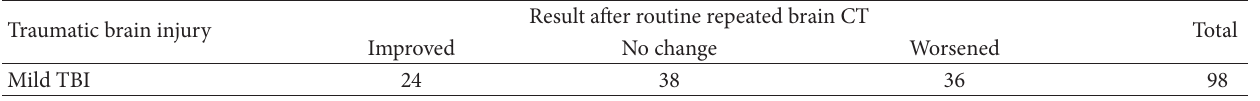
Table 5: Comparison of the result of routine repeated brain CT versus initial brain CT in mild TBI.